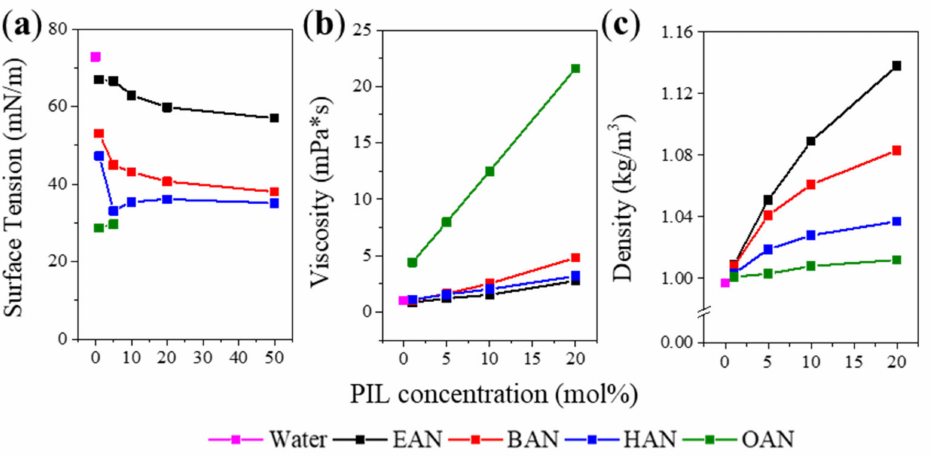
Figure 2. Physicochemical properties of PIL solution as a function of PIL concentration (0 mol% corresponds to water) measured at 20 ◦ C for ( a ) surface tension, ( b ) viscosity and ( c )